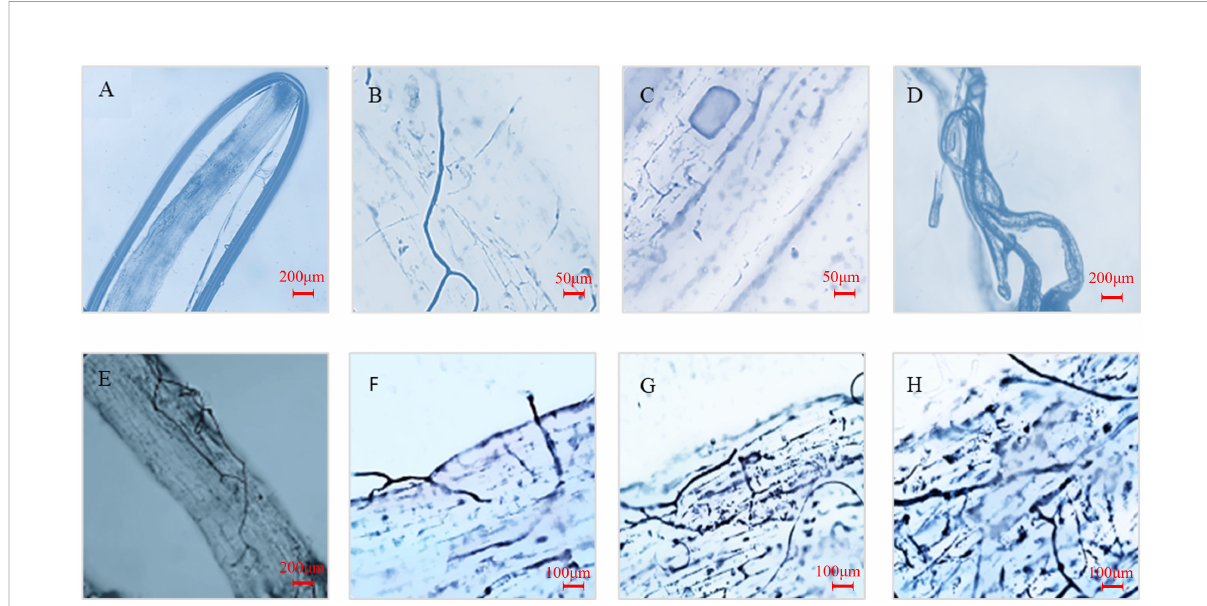
FIGURE 1 Mycorrhizal phenotype of seedling roots inoculated with R. intraradices after 12 d of drought treatment. (A) Roots of seedlings not inoculated with AM fungi; (B – D) Hyphae, vesicles and arbuscules in roots after mycorrhizal infection; (E, F) : Mycorrhizal infection of roots without external melatonin treatment; (G, H) Mycorrhizal infection of roots treated with external